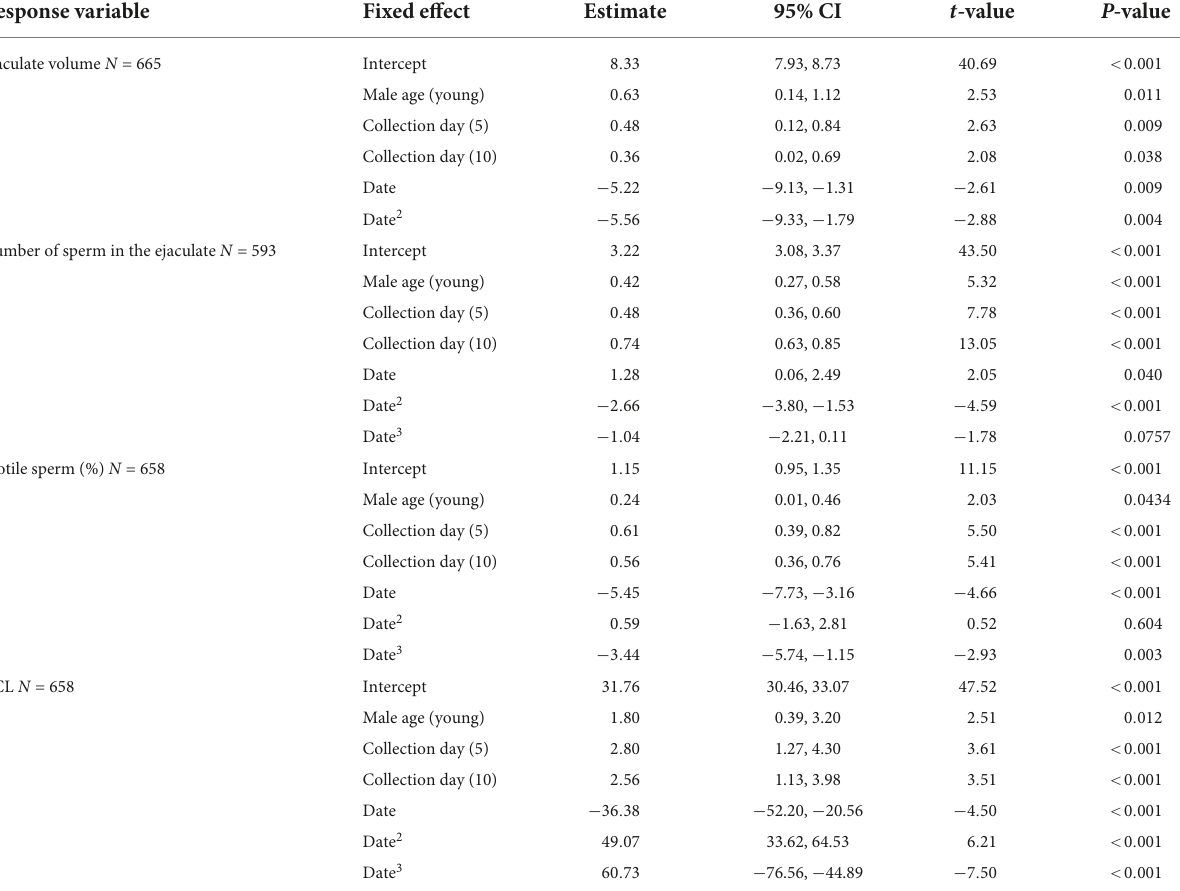
TABLE 1 Selected parsimonious linear mixed models exploring the effect of male and sperm age on the ejaculate volume, the number of sperm in the ejaculate, the percentage of motile sperm (on the logit scale), and the curvilinear velocity (VCL). Response